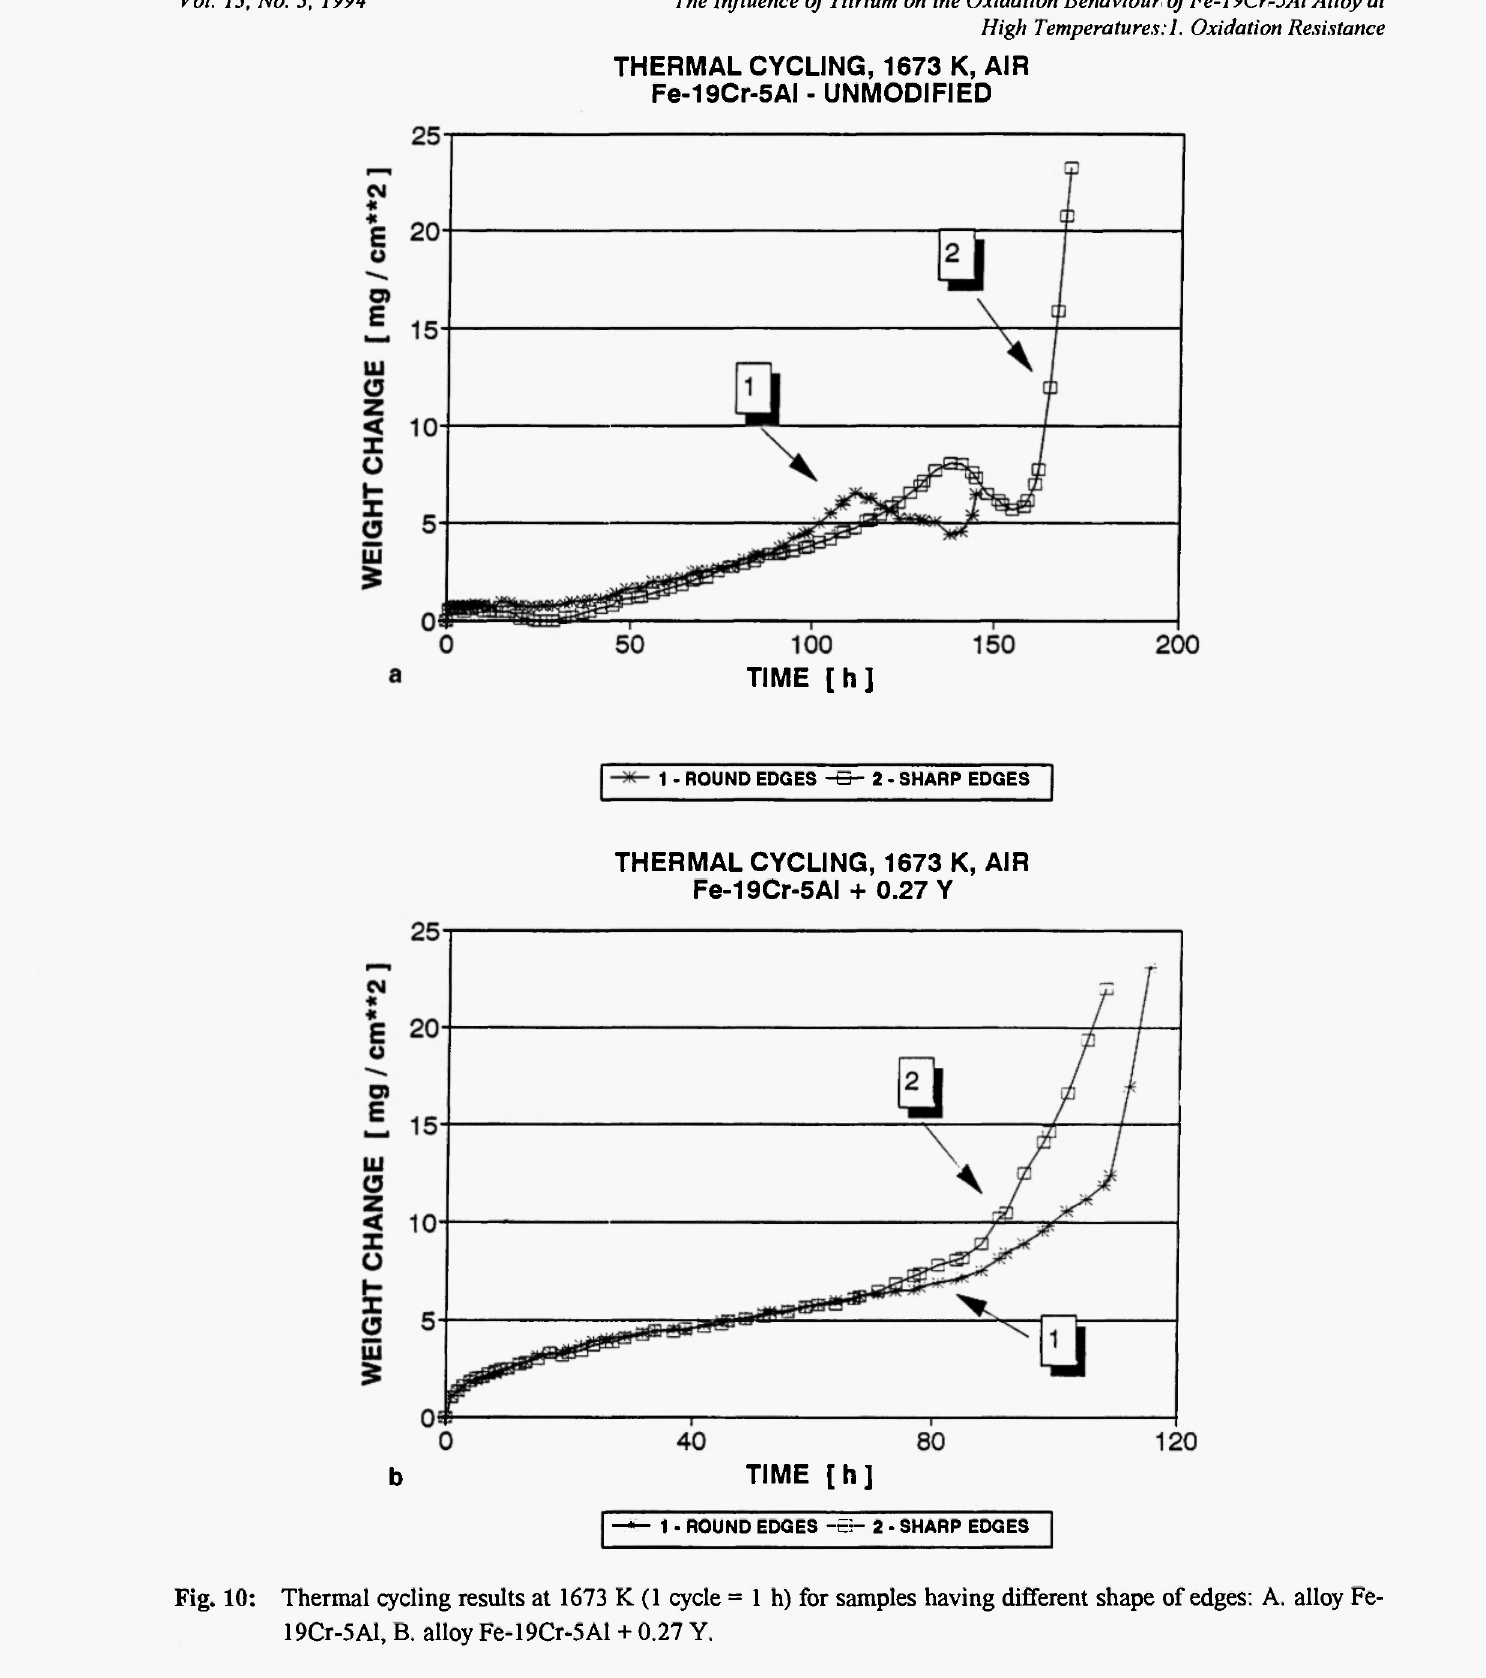
Fig. 10: Thermal cycling results at 1673 Κ (1 cycle = 1 h) for samples having different shape of edges: A. alloy Fe- 19Cr-5Al, B. alloy Fe-19Cr-5Al + 0.27